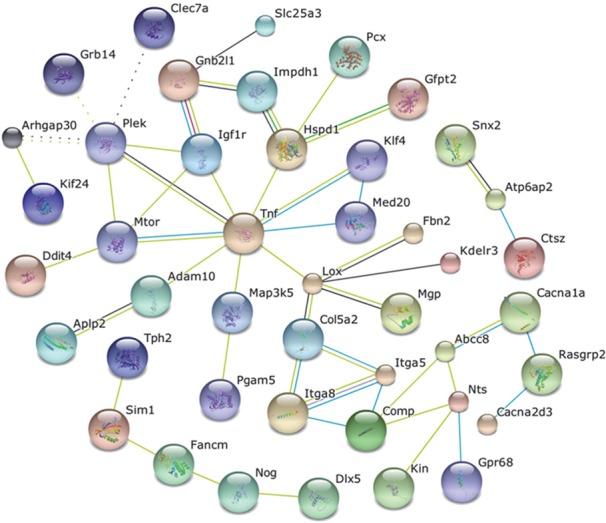
Bioinformatics network analysis of miRNA target genes.The target genes of the 52 miRNAs significantly altered in the circulation after partial hepatectomy were analyzed using the miRror program. Three hundred and five genes were predicted, and network analysis of these genes using String 9.05 indicated interactions amongst several identified targets.